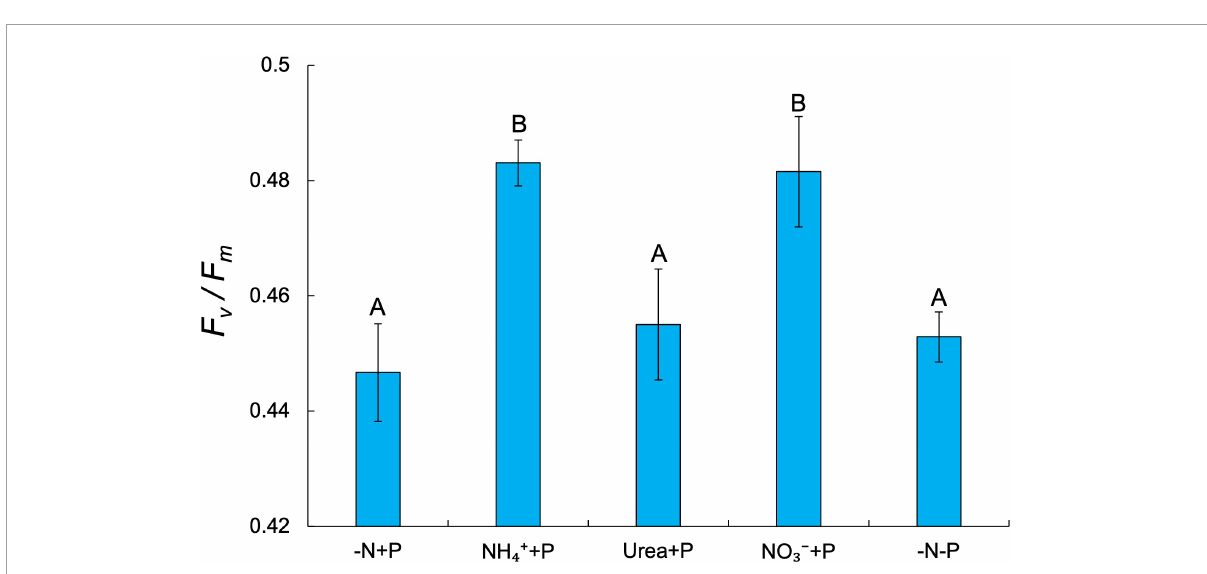
FIGURE2 Photosystem II photosynthetic efficiency ( F v /F m ) across treatments. Error bars represent standard deviation. Letters above bars represent significant differences between experimental groups (Two-way ANOVA; Tukey’s HSD post hoc ; p < 0.05).